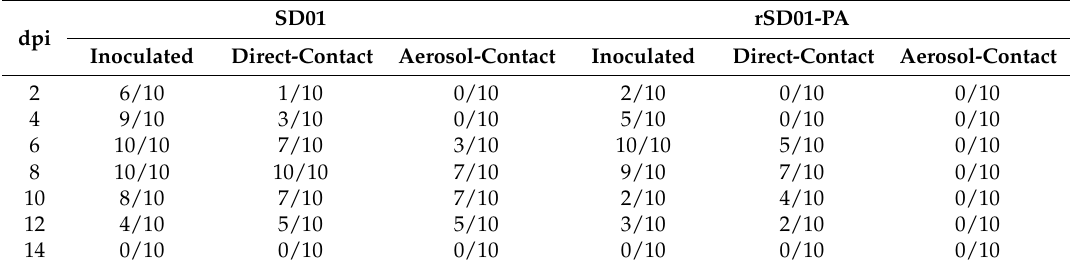
Table 3. Number of SPF chickens infected with a virus in the transmission experiments *.